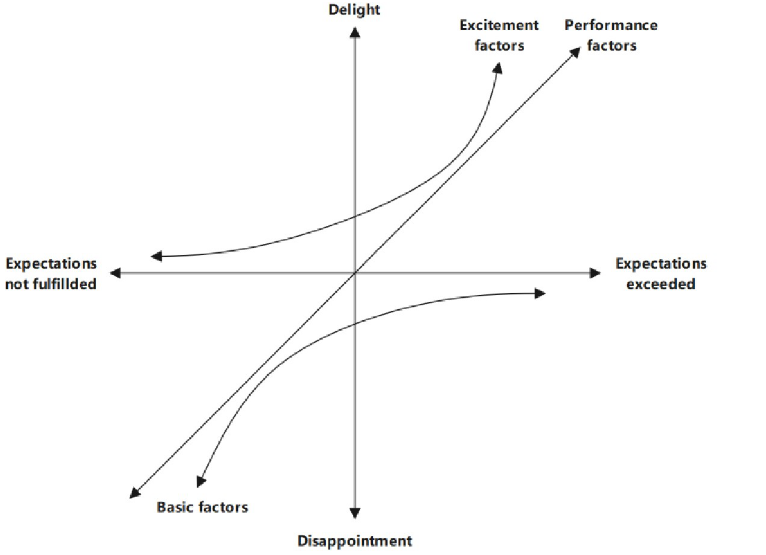
Fig 4. The three-factor theory of customer